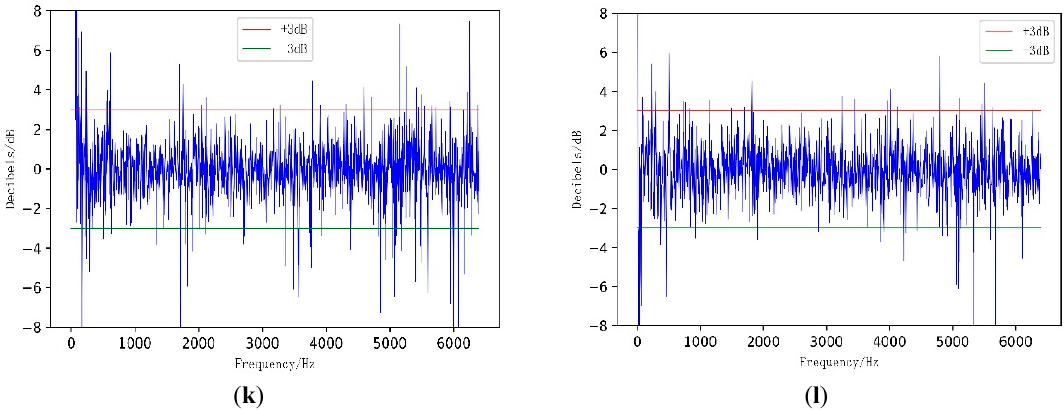
Figure 4. Energy dB error of the different methods. ( a ) t1 = 1. MIMO LS-SVR. ( b ) t2 = 5. MIMO LS-SVR. ( c ) t1 = 1. MIMO LS-SVR with loads. ( d ) t2 = 5. MIMO LS-SVR with loads. ( e ) t1 = 1.